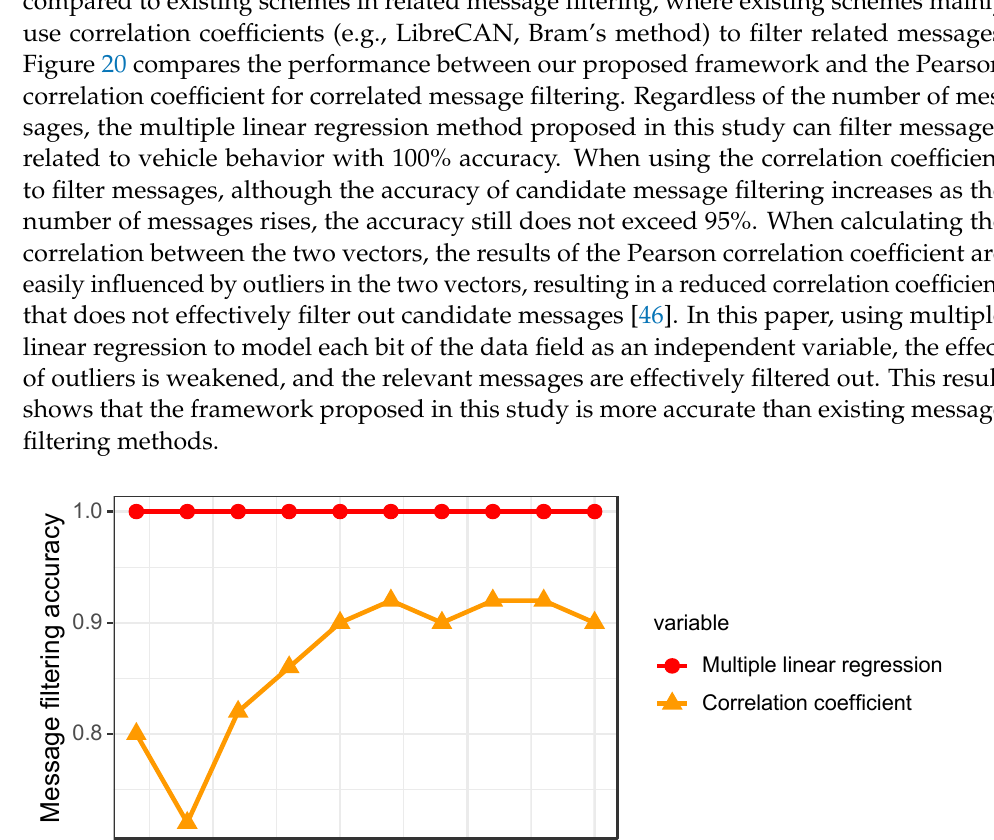
Table 11. The influence of different message counts on accuracy.